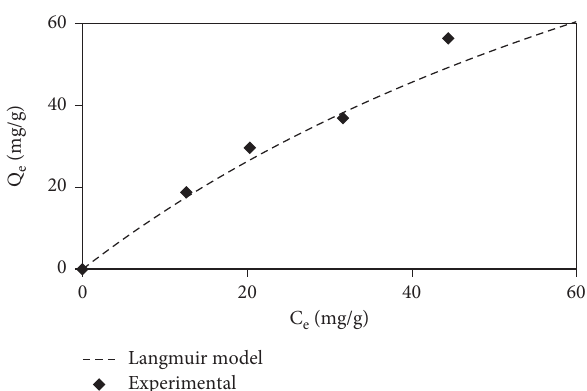
Figure 19: Modeling of the isotherm adsorption by Langmuir model.